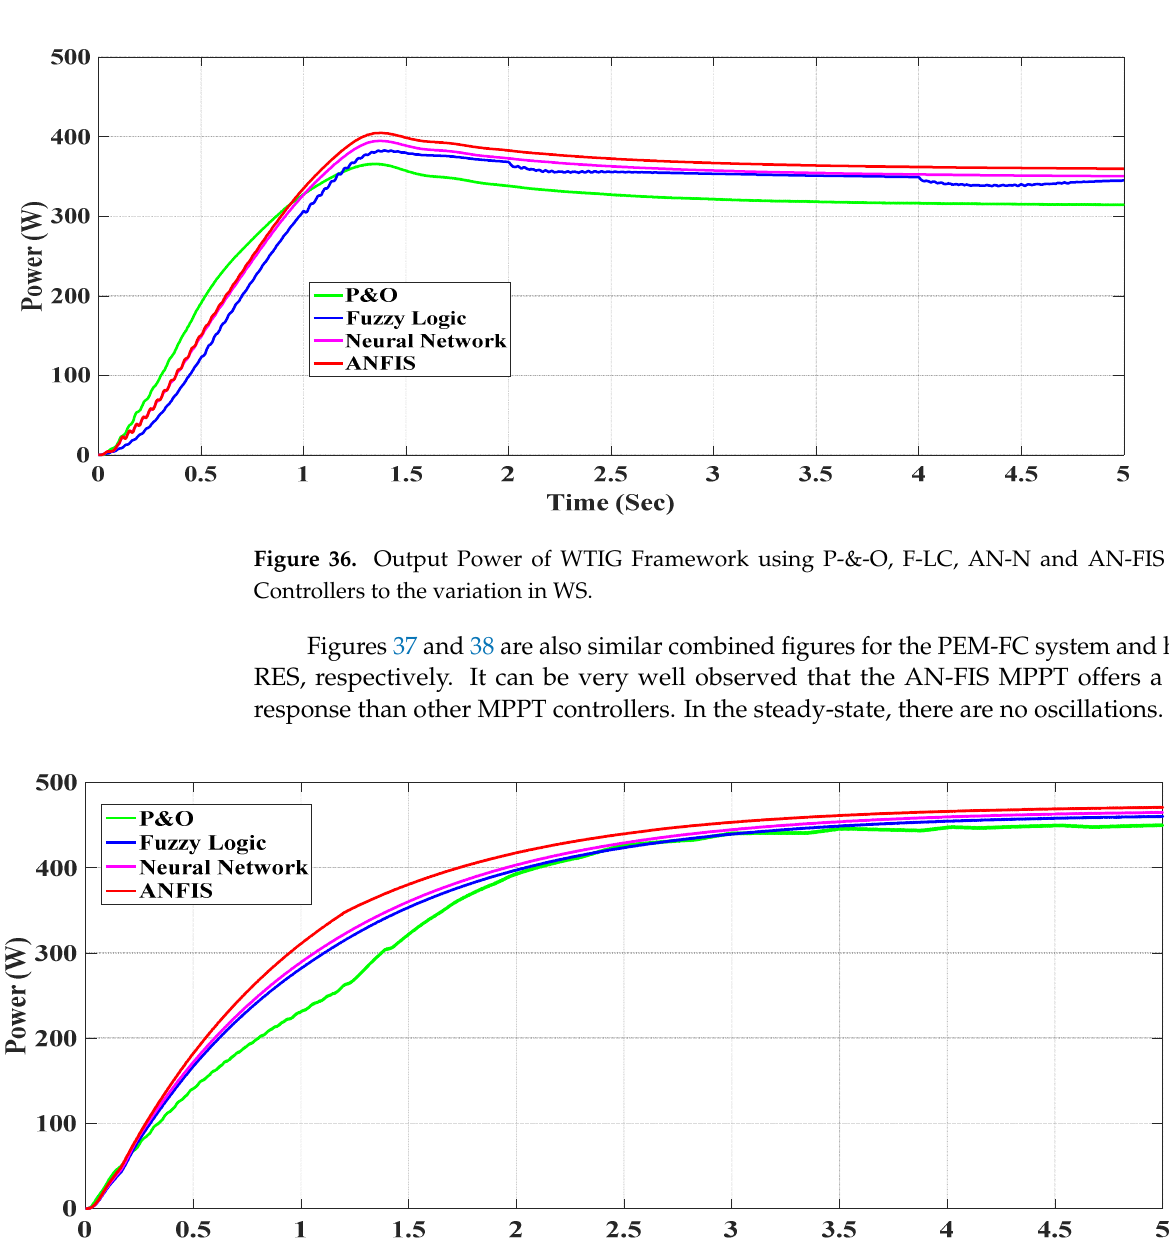
Figure 37. Output Power of PEM-FC using P-&-O, F-LC, AN-N and AN-FIS MPPT to the deviation in HFR.